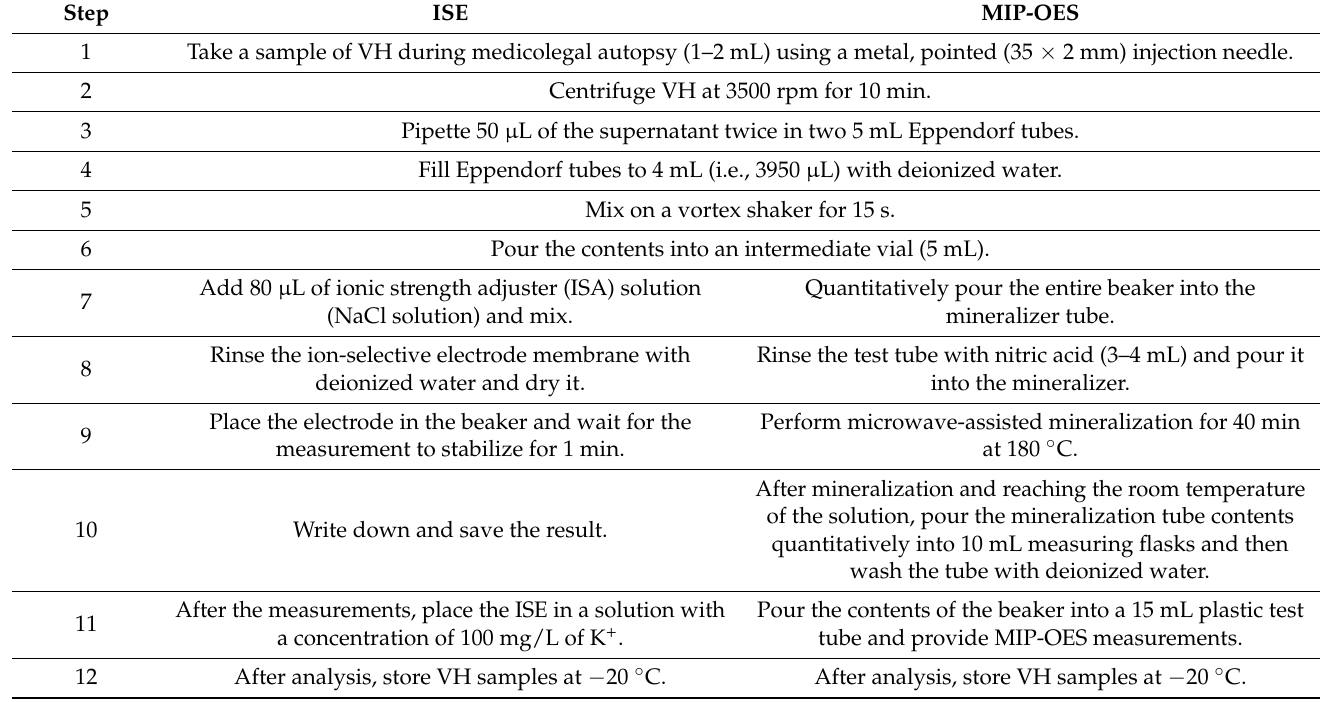
Table 4. Procedure for determining potassium ion concentration in VH by ISE and MIP-OES